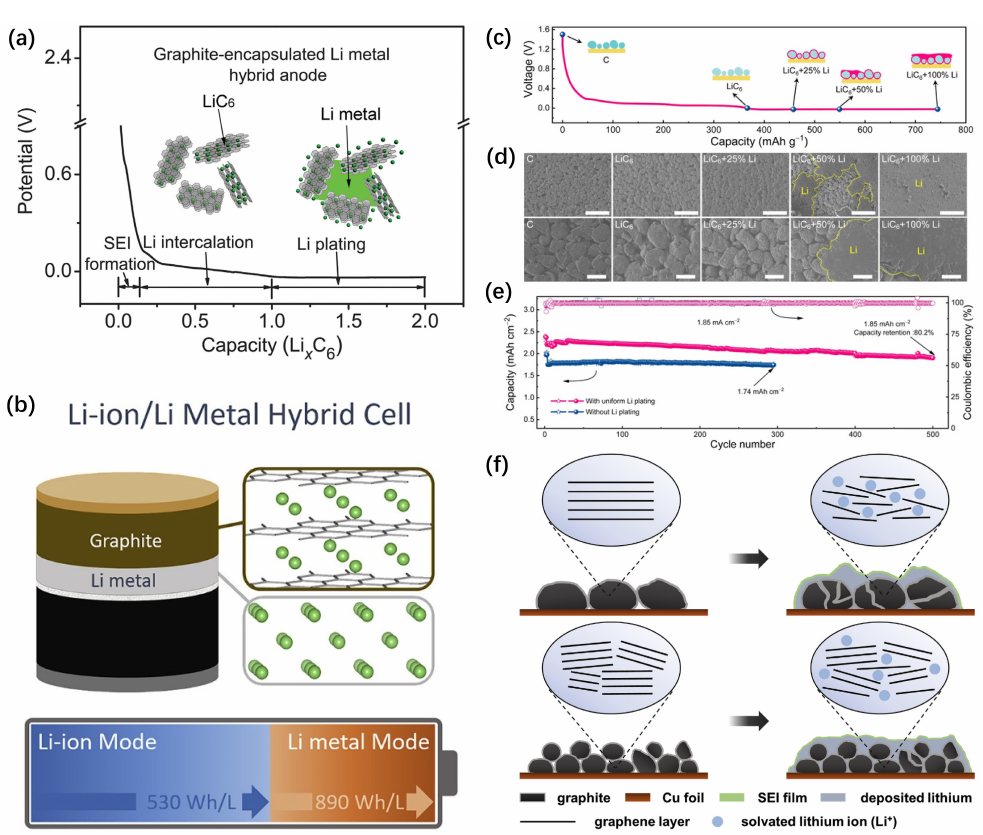
Figure 10. ( a ) Voltage variation of Li metal deposition in bulk artificial graphite [126]. ( b ) Schematic and specific energy of the hybrid Li-ion/Li-metal battery [122]. ( c , d ) Characterization of the mor- phological evolution of lithium intercalation and electroplated graphite electrodes. ( e ) Electrochem- ical performance of the lithium–graphite composite battery with localized highly concentrated elec- trolyte [128]. ( f ) Schematic illustration of the effects of NG and BMG structures on Li deposition and carbon structure evolution [129].